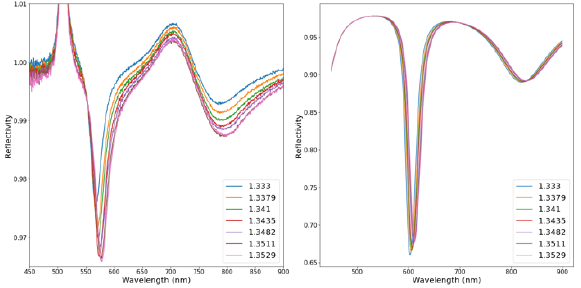
Fig. 3. Reflectivity spectra of BSW wave supported on a photonic crystal: a) Experimental results, b) transfer matrix simulations.